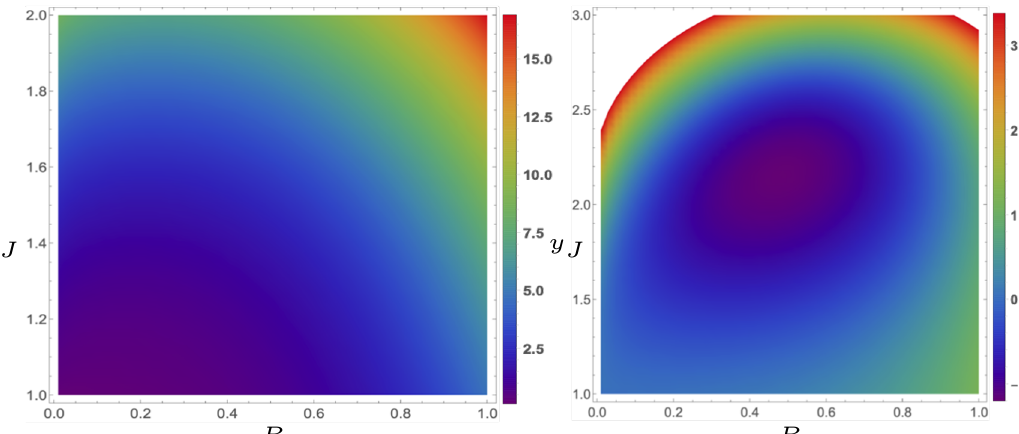
Figure 7 . Numerically computed values of K − 1 ∆ S DBI ( y J , B ) for two different values of ˜ L . On the left ( ˜ L = 1 ), the minimum is at y J = 1 , B → 0 and therefore the disconnected solution is preferred. On the right ( ˜ L = 0 . 5 ), the minimum is at y J = 2 . 15 , B = 0 . 48 , the connected solution has lower energy and chiral symmetry breaking is to be expected. It is interesting to notice that the disconnected solution ( y J = 1 , B → 0 ) remains a local minimum of the action in all the cases.